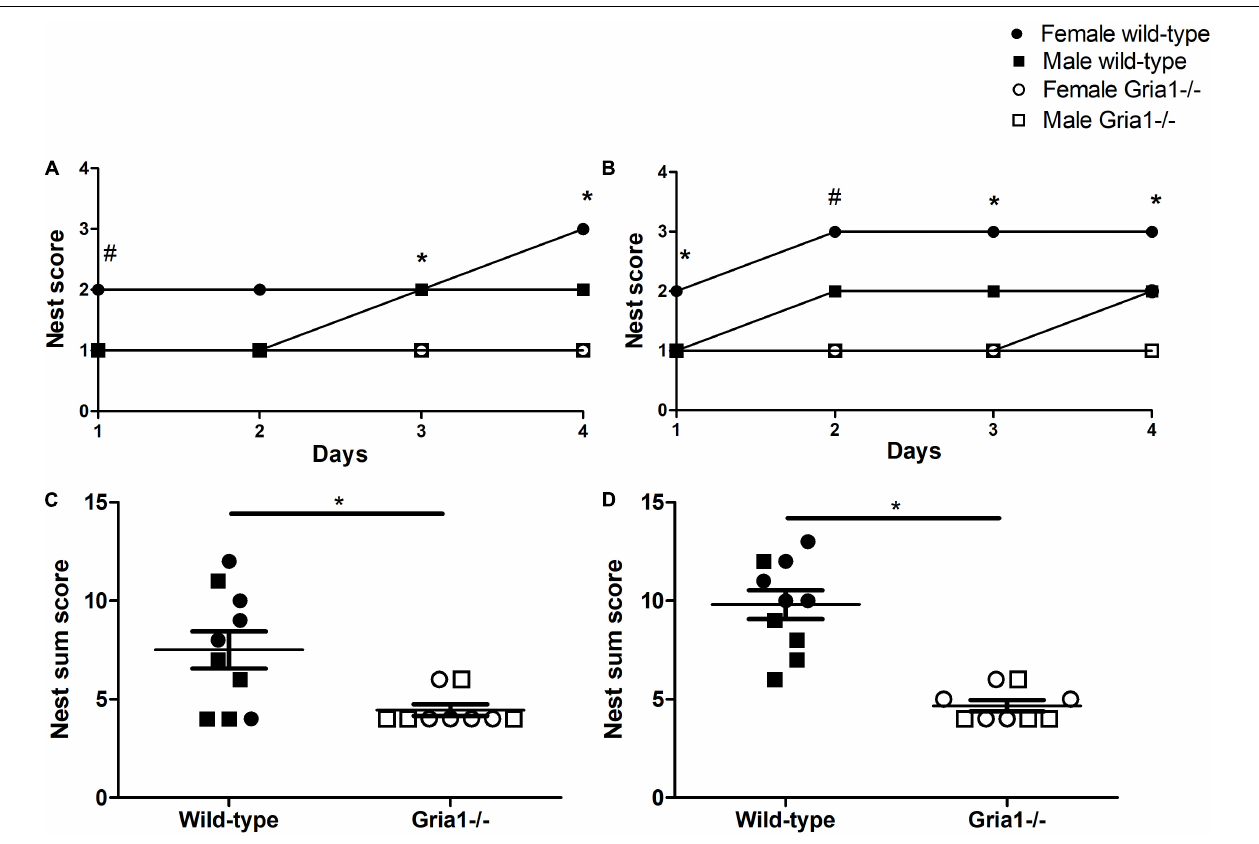
FIGURE 3 | Nest building performance and nest complexity. The assessment of nest building performance during the 4-day observation period showed that in prepubescent (A) and sexually mature mice (B) mice, a significant effect of genotype on nest complexity scores was detected for several of the four observation days. Genotype significantly interacted with sex, reflecting decreased nest scores in female Gria1 − / − mice when compared to female wild-type littermates on the first day in prepubescent mice (A) and on the second day in sexually mature mice (B) . The analysis of nest complexity sum scores revealed significantly decreased scores in prepubescent (C) and sexually mature (D) Gria1 − / − mice as compared to wild-type littermates. ART ANOVA, followed by FDR correction or Bonferroni multiple comparison post hoc tests. n = 4–5 per genotype per sex. * p < 0.05 and # p < 0.05 (females). (A,B) Illustrate the median, in (C,D) error bars indicate the standard error of the mean (SEM).